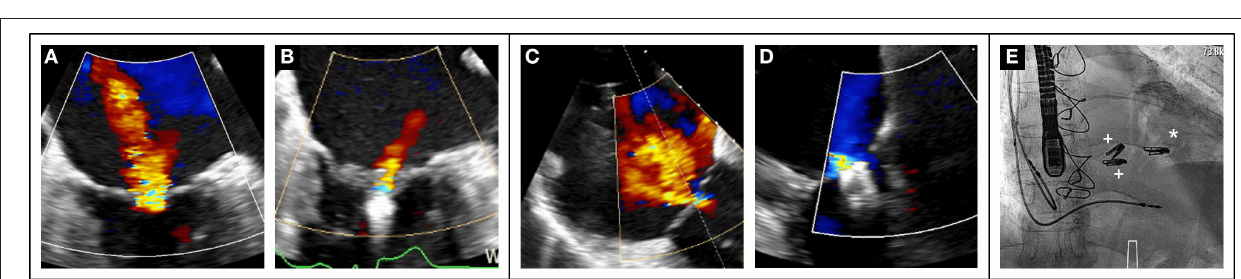
FIGURE 2 | Decision algorithm for transcatheter tricuspid valve interventions. TR, tricuspid regurgitation; OMT, optimal medical therapy; PHT, pulmonary hypertension; RV, right ventricle.